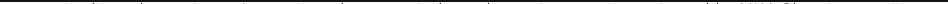
Fig. 4 Interactions between indicated proteins. a, Interactions between indicated proteins were investigated by Y2H. Plus sign, positive control; minus sign, negative control; QD + AbA, quadruple-dropout medium lacking Ade, His, Leu and Trp containing 200 ng/mL AbA; DD, double- dropout medium lacking Leu and Trp. b, c, d, and e, pull-down results of four pairs of proteins: MKKK62-MKK3, MKKK62-MKK10 – 2, MKK3-MAPK7, and MKK3-MAPK14, respectively. Binding of GST- and His-fusion proteins was tested by immunoblotting using anti-His after pull-down with GST- fusion protein. GST was used as negative control. Expression of fusion proteins was detected using antibody to the tag. “ Input ” indicated the detection result of the fusion proteins with anti-His or anti-GST antibody; “ Pull-down ” indicated the detection result of His-fusion protein binding to GST-fusion protein with anti-His antibody. Arrow indicates the band of the target protein